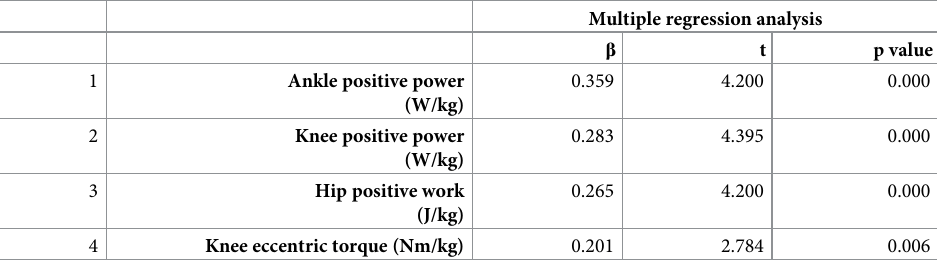
Table 3. Multiple regression predictors of jump